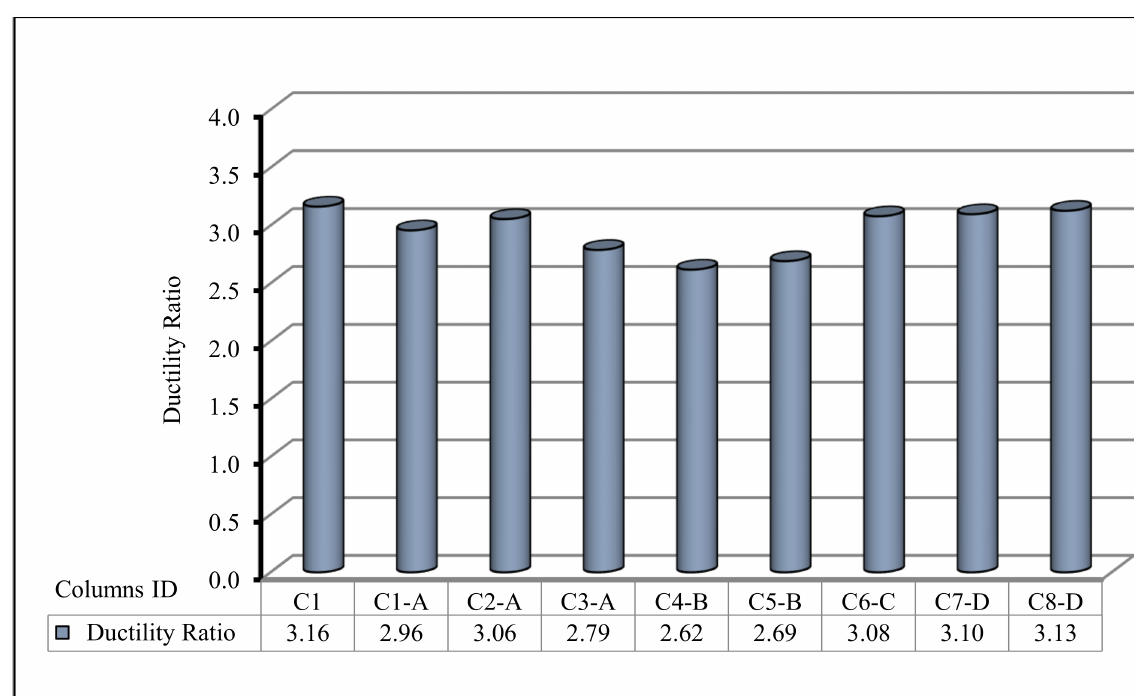
Figure 13. Ductility ratio for the tested